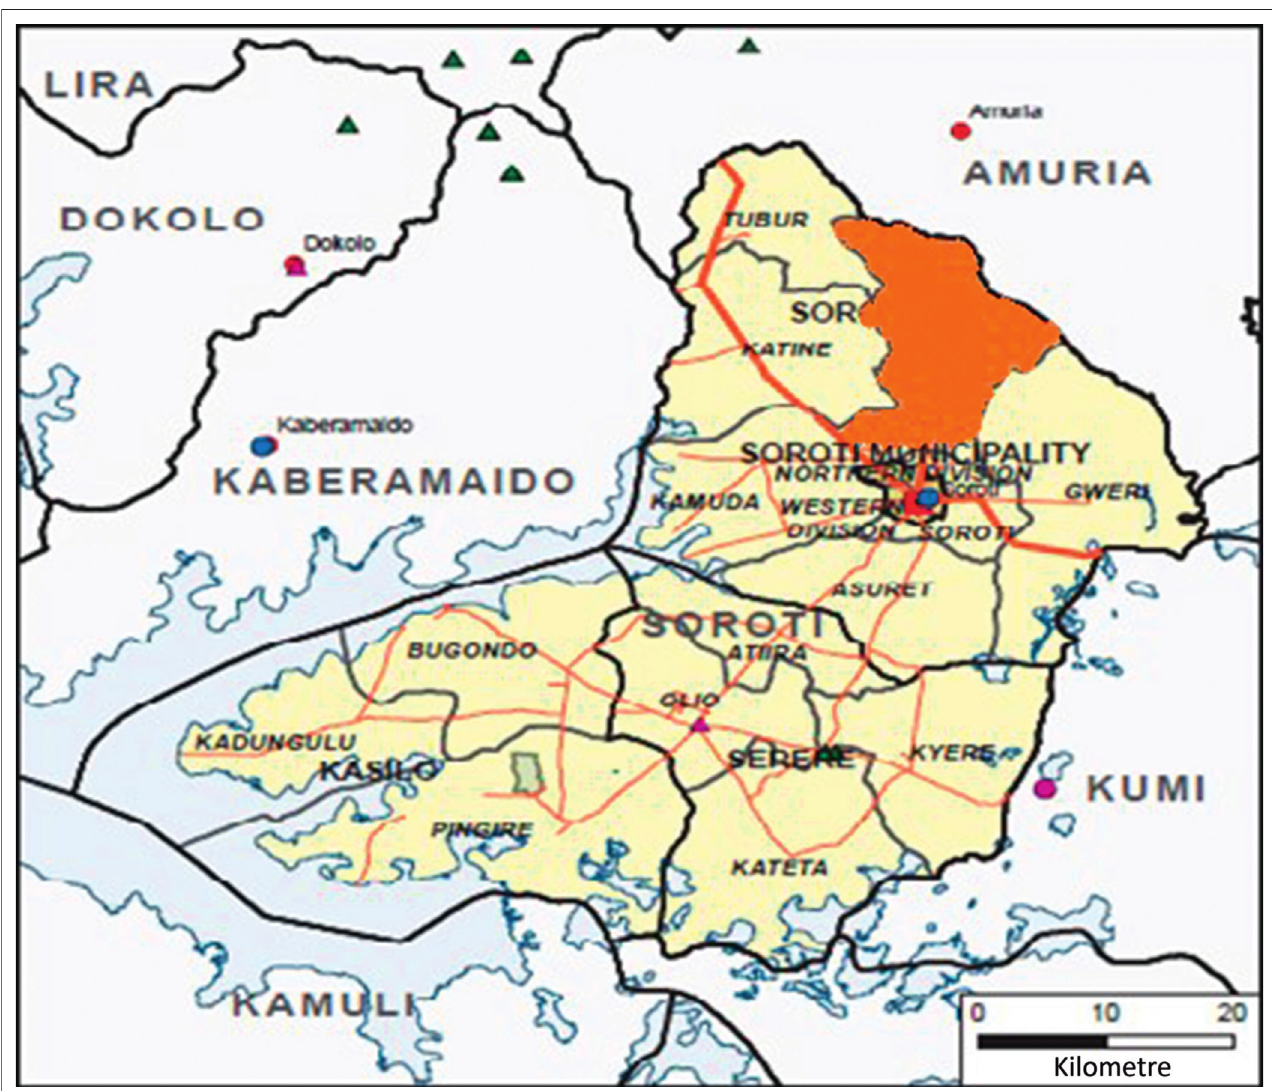
FIGURE 2: Map Soroti District showing location of Arapai